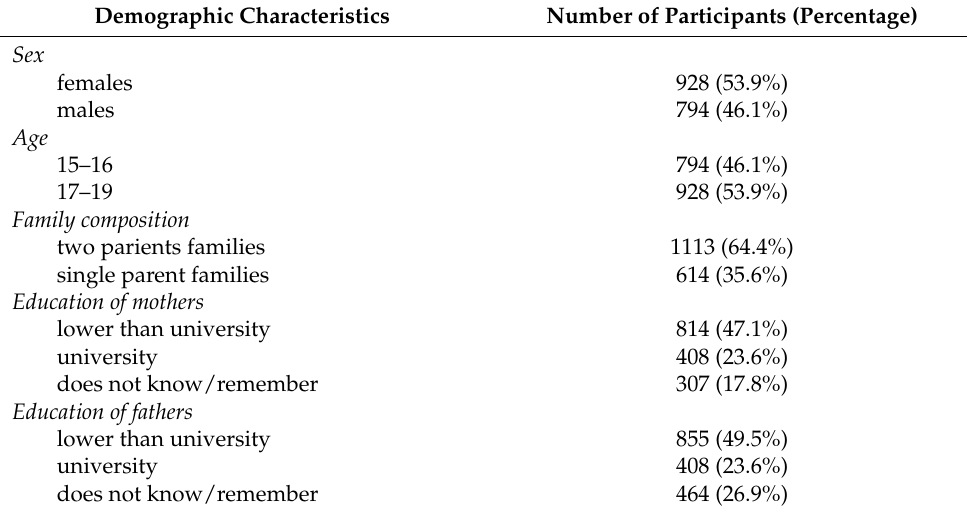
Table 1. Sociodemographic